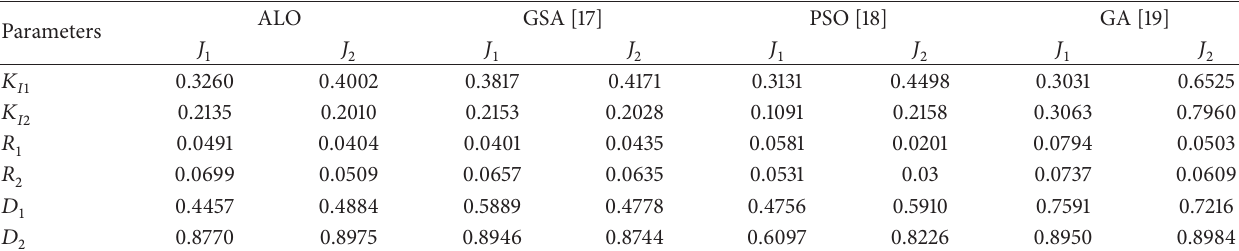
Table 1: Optimized parameters of AGC